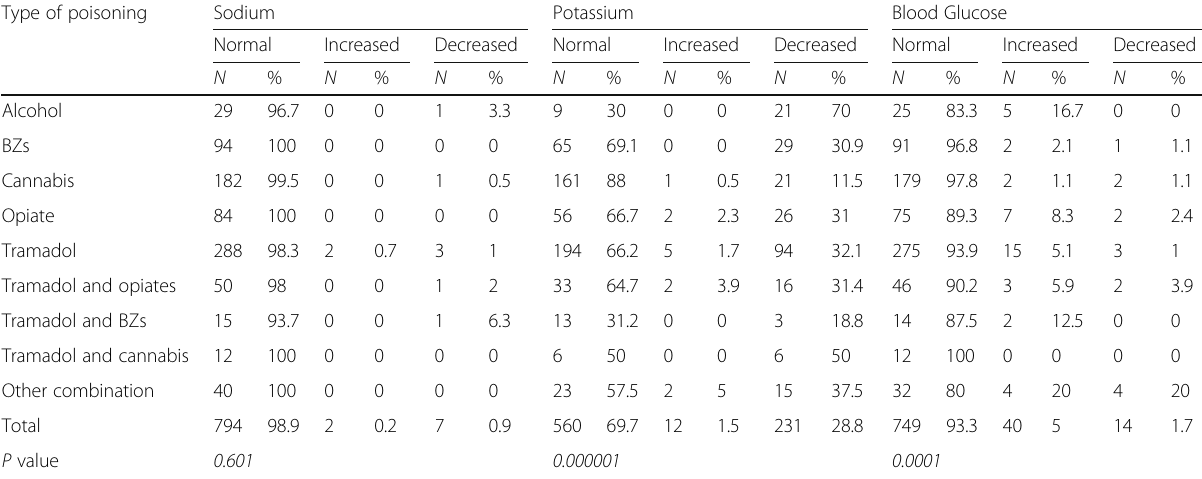
Table 5 The effect of addictive drug-induced acute toxicity on serum electrolytes and blood glucose level among patients under the study Type of poisoning